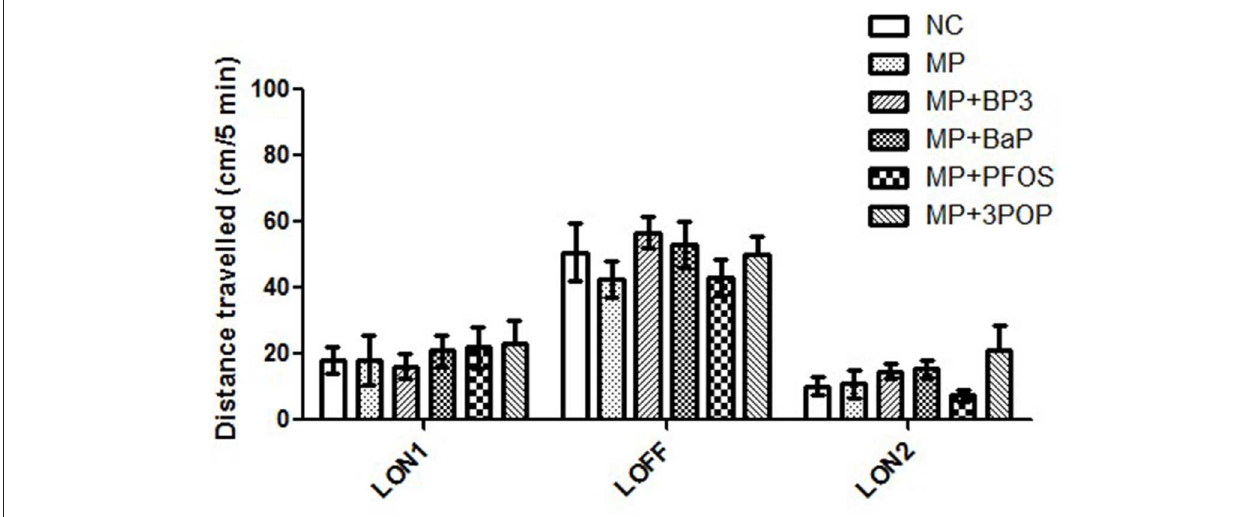
FIGURE 5 | Larval photomotor response in 5 days old zebrafish ( Danio rerio ) embryos after exposure to 10 mg/L of microplastics. Distance traveled over 5 min periods including two light-on periods (LON-1, LON-2) and one light off period (LOFF). Data are given as means ± SD ( n = 16–24 larvae per treatment; repeated–measure